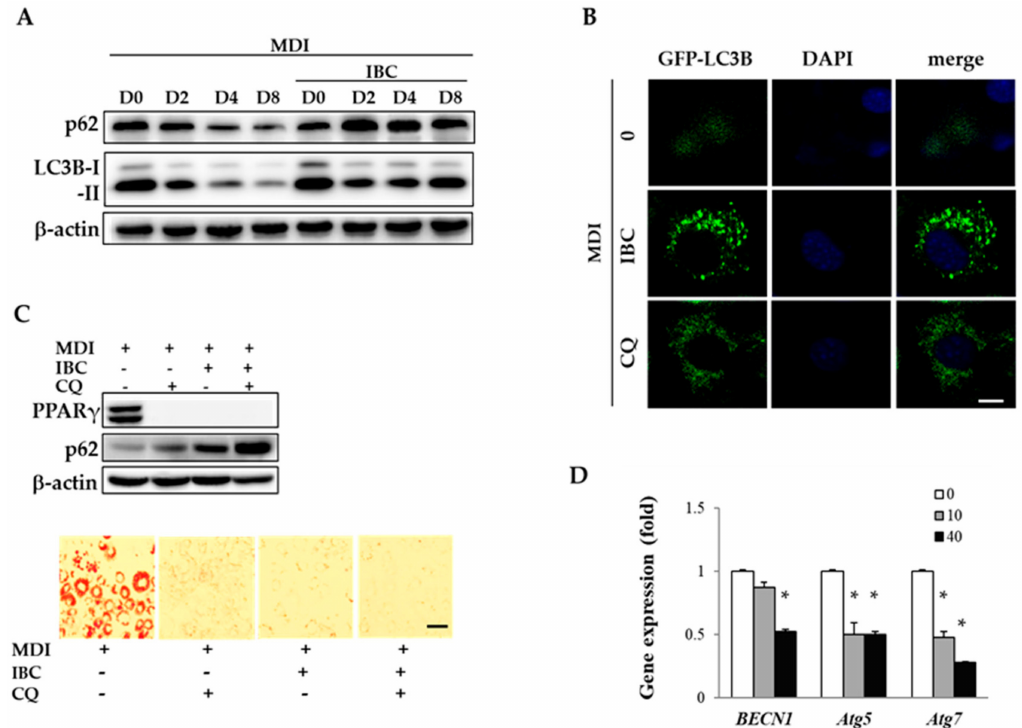
Figure 5. Effect of IBC on autophagic flux during adipocyte differentiation. ( A ) 3T3-L1 adipocytes were differentiated in the presence or absence of 40 µ M of IBC. Differentiating adipocytes were harvested at the indicated period and lysed for Western blotting analysis to determine levels of LC3B and SQSTM1/p62; ( B ) Preadipocytes were transfected with GFP-LC3 plasmid and differentiated with MDI in the presence of IBC or CQ (10 µ M) during D0–D2, followed by additional treatment with differentiation medium for 2 days (D4). Cells were fixed and stained with DAPI (nuclei, blue-colored). Intracellular GFP-LC3 puncta (green-colored) were visualized with a confocal laser microscope. Scale bar = 10 µ m; ( C ) Differentiating adipocytes supplemented with IBC or CQ during D0–D2 were harvested and protein levels of PPAR γ and SQSTM1/p62 were analyzed on D8. Scale bar = 100 µ m; and ( D ) On D2, differentiating adipocytes supplemented with IBC or CQ were harvested and subjected to qPCR to analyze gene expression levels of BECN1 , Atg5 , and Atg7 . Data are presented as means ± SD of triplicate experiments. * p < 0.01 vs. MDI